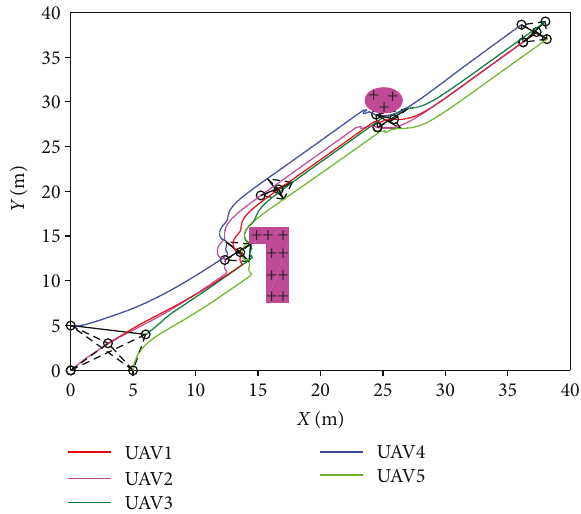
Figure 23: The consensus formation with 3D optimal rigid